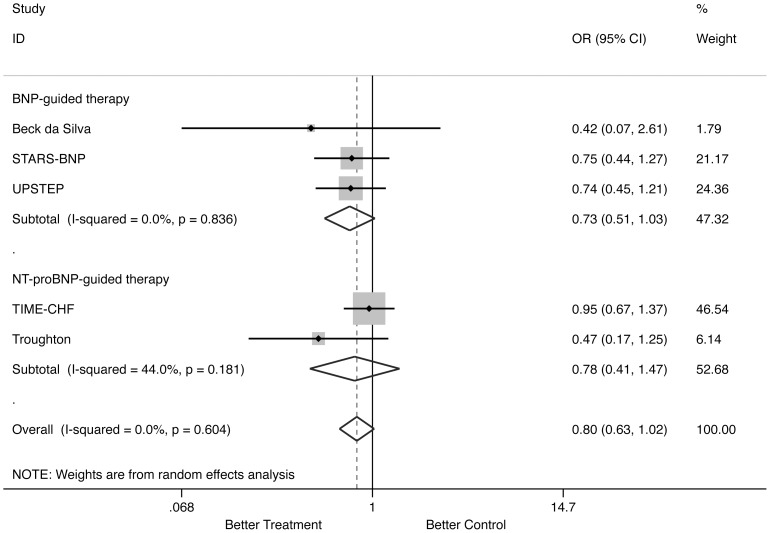
Odds ratios of all-cause hospitalization.Solid squares represent odds ratios in trials and have a size proportional to the number of events. The 95% confidence intervals for individual trials are denoted by lines and those for the pooled odd ratios by empty diamonds.